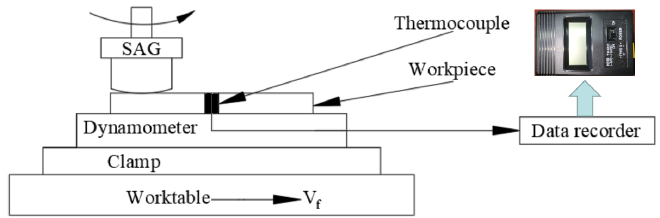
Figure 11. Temperature measurement diagram of K thermocouple.